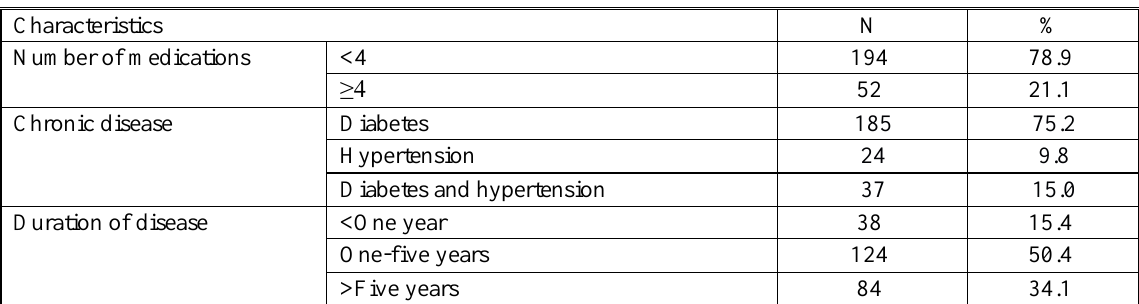
Table 2.Medical characteristics of the